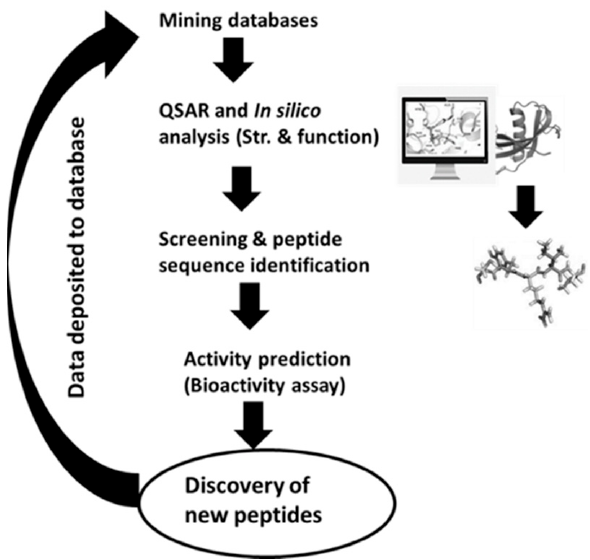
Figure 2. In silico approach to identify peptides from unknown sources of protein. QSAR: quantitative structure–activity relationship, Str: Structure. Table 6. In silico databases and online tools for analysis of bioactive peptides.